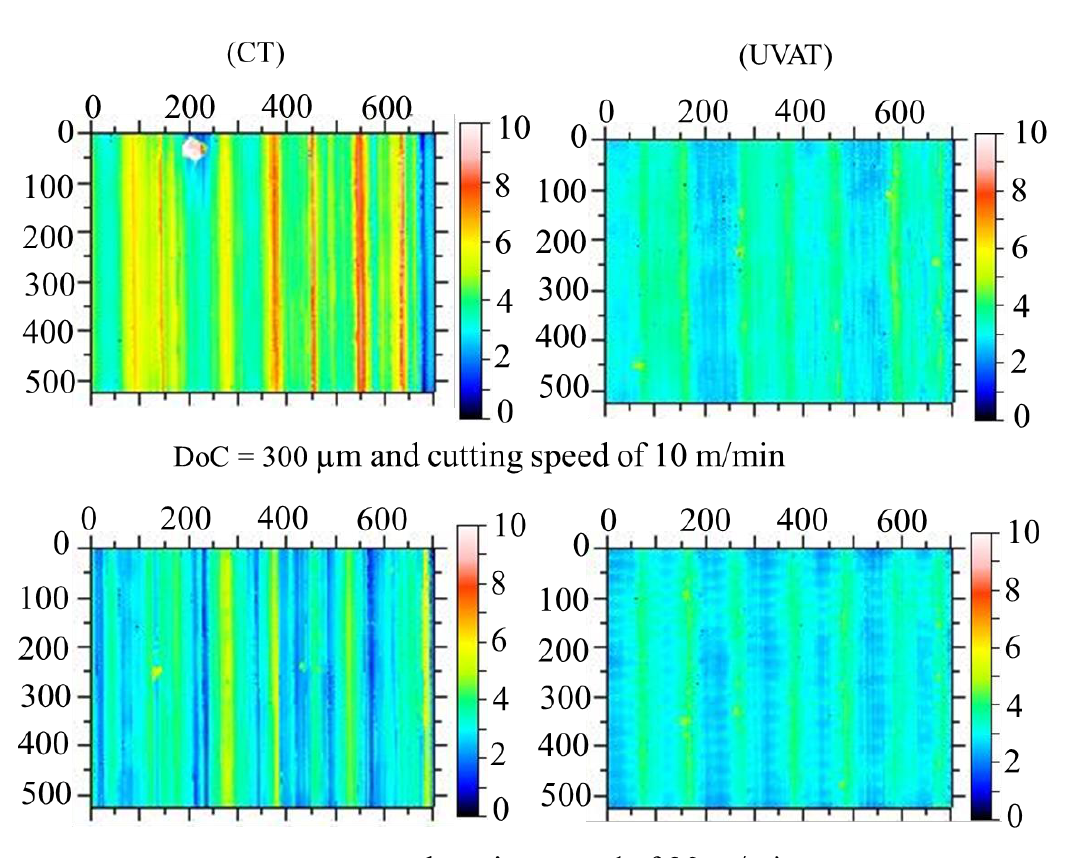
Figure 14. Optical scans of machined surfaces.